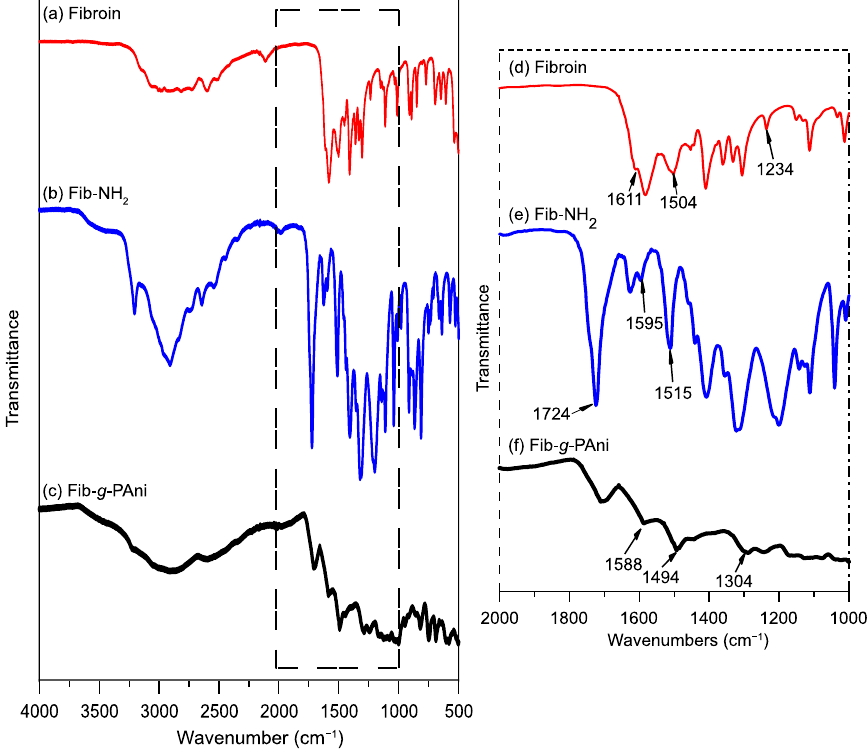
Figure 3. FT-IR spectra ( a – c ) and zoom ( d – f ) from 1000 to 2000 cm – 1 of these spectra. ( a , d ) Fib, ( b , e ) Fib-NH 2 , and ( c , f ) Fib- g -Pani 1:0.5. ( b , e ) Fib-NH 2 , and ( c , f ) Fib- g -Pani